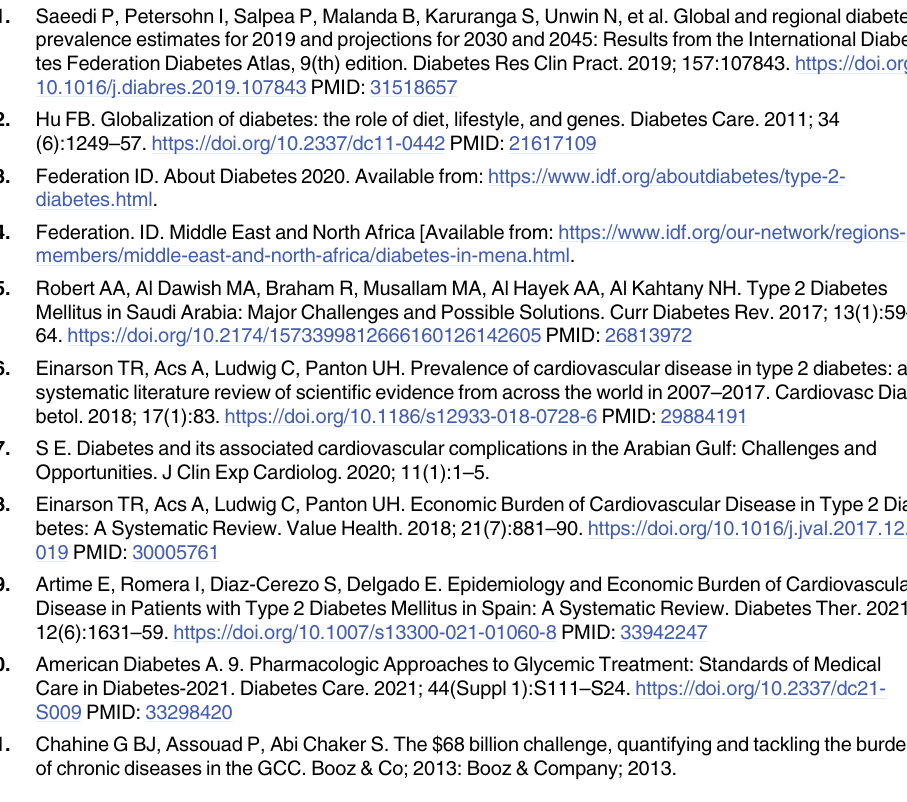
S21 Table. Comparison of pre-index and post-index disease-specific cause cost for various activities (Payer 3, Cohort 1). S22 Table. Comparison of pre-index and post-index disease-specific cause cost for various activities (Payer 3, Cohort 2). S23 Table. Comparison of pre-index and post-index disease-specific cause cost for various activities (Payer 3, Cohort